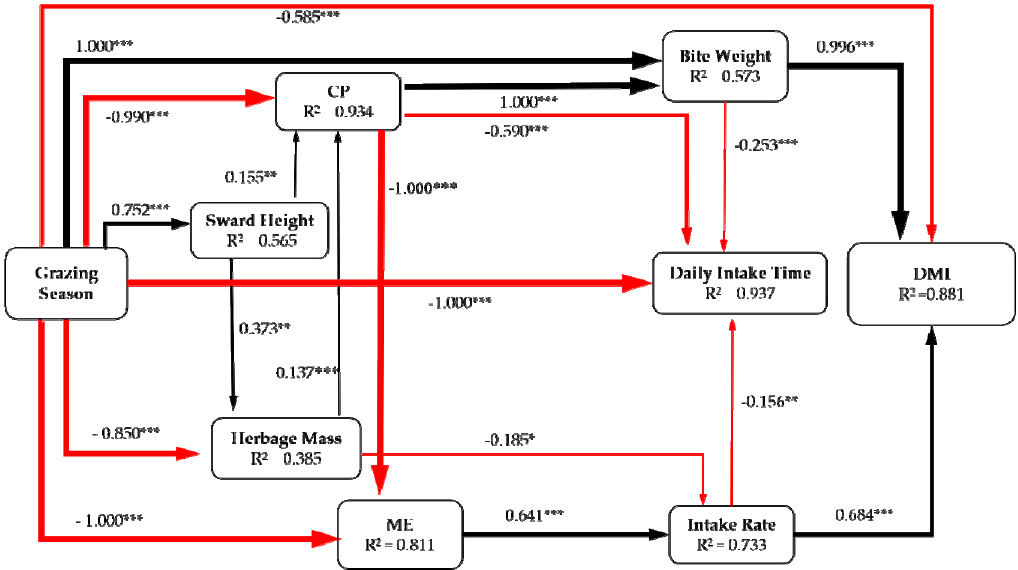
Figure 9. Structural equation modeling (SEM) showed the effect of grazing season on dry matter intake (DMI). The evaluation for grazing season: warm season = 1, cold season = 2. The SEM considered all plausible pathways (sward height, herbage mass, crude protein (CP), metabolic energy (ME), intake rate, bite weight, diurnal intake time) through which stocking rate influences the DMI. The arrows reflect the causal relationships, and the thickness of the black (positive) and red (negative) paths is proportional to the range–standardized path coefficients. * p < 0.05, ** p < 0.01, *** p < 0.001. The model shows a fitted result ( χ 2 = 0.432, df = 13, p = 0.934; RMSEA = 0.053, p = 0.651; GFI > 0.986).